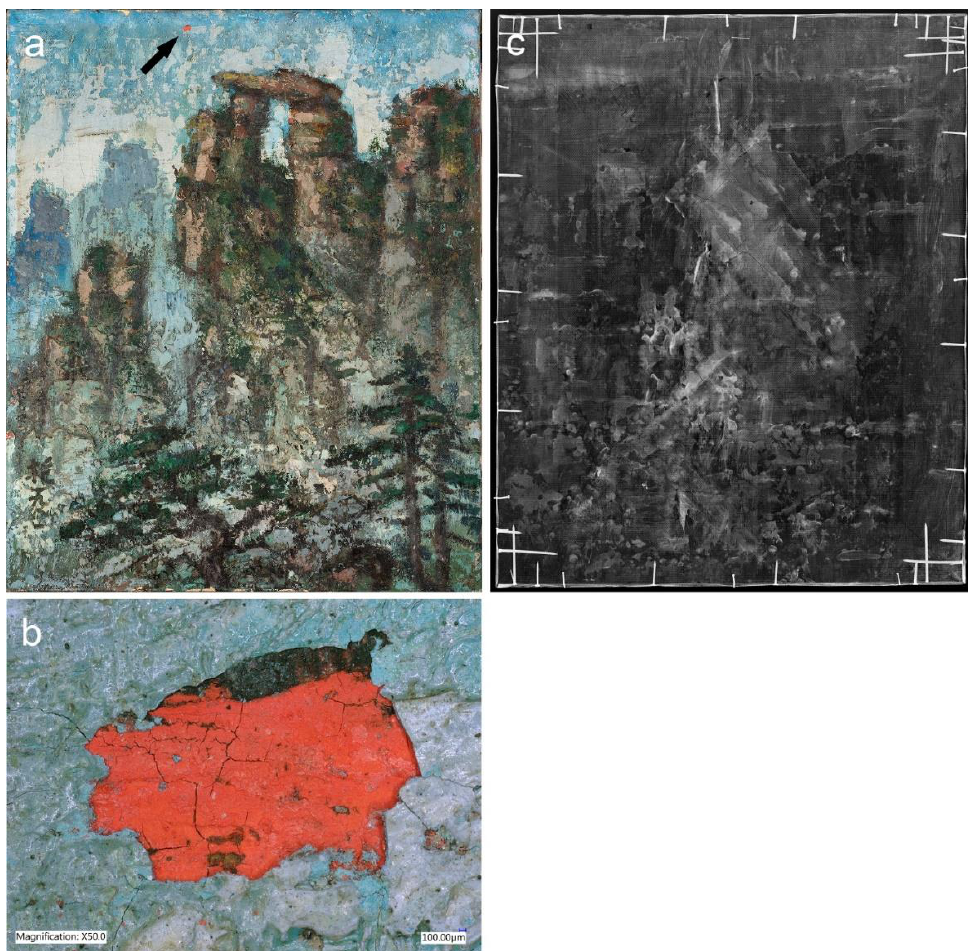
Figure 23. ( a ) Image of Mountain , 1981, photographed in VIS with the marked location of paint loss revealing a different paint scheme beneath the current composition. ( b ) Corresponding XRR image showing a poor rendering of the underlying composition. ( c ) Digital microscope image of red and black paint layer discernible through the paint loss of the same painting.